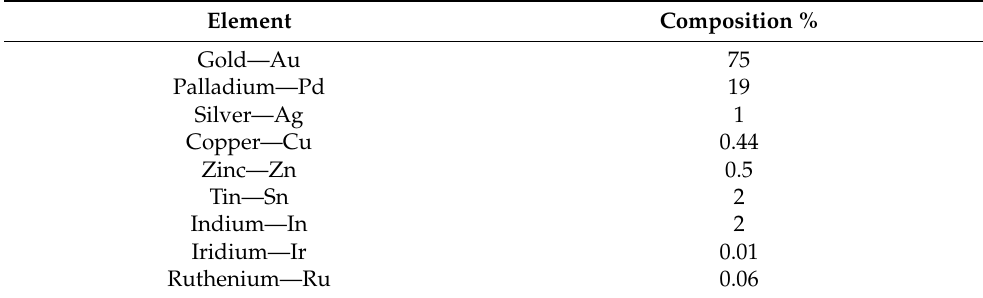
Table 1. Composition of the gold alloy V